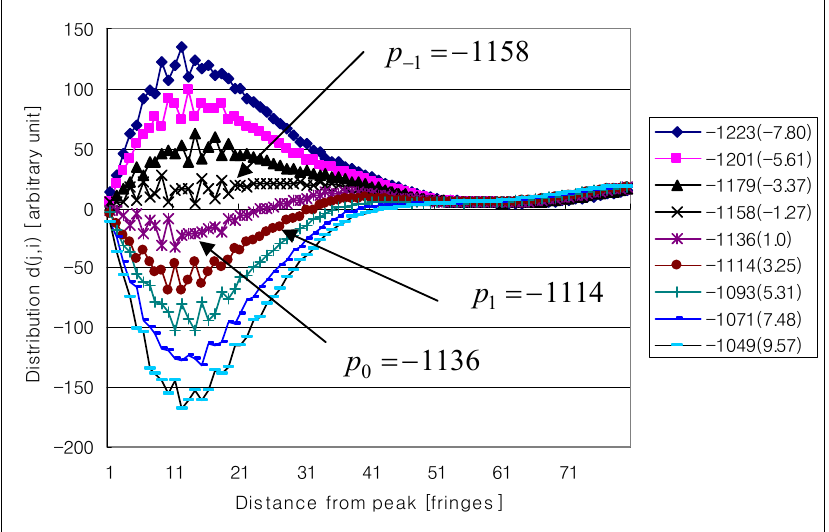
Figure 7 . Distribution ),( ijd of fringe scan